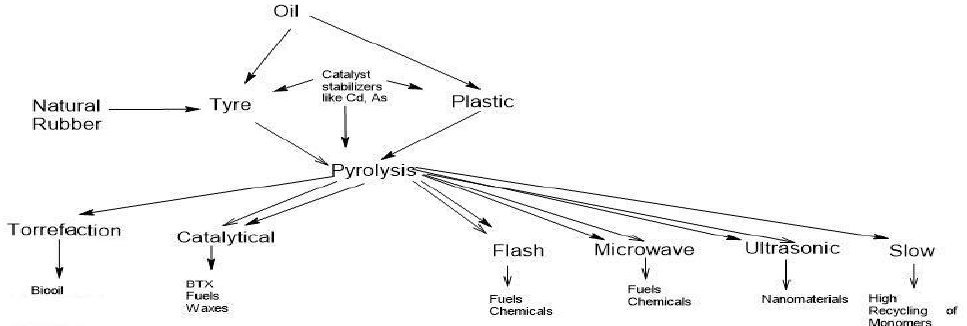
Figure 3. Life cycle from oil, composites and energy [135].